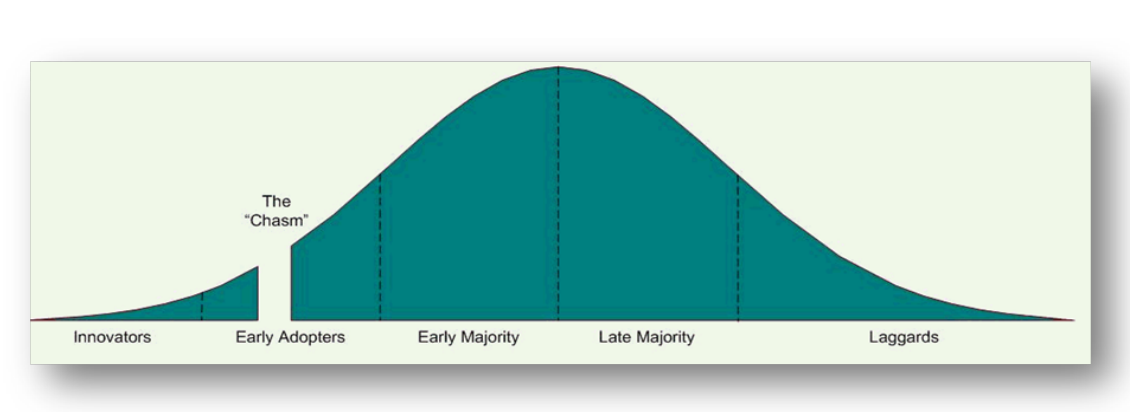
Figure 1 . Technology adoption lifecycle (Moore, 1991 after Rogers,